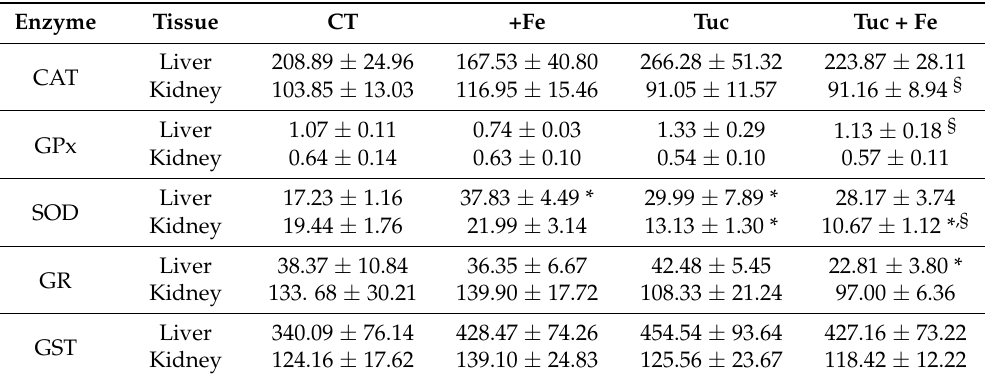
Table 4. Effect of iron and/or tucum-do-cerrado intake in antioxidant enzymes activity in the liver and kidney of adult rats treated for 12